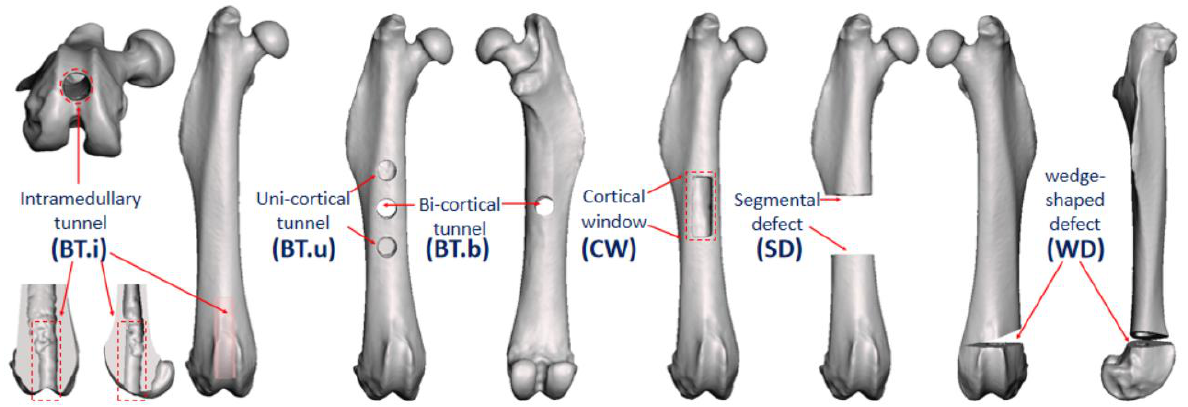
Figure 5. Classification of modeling methods. Note: BT.i: bone tunnel, intramedullary; BT.u : bone tunnel, uni-cortical; BT.b : bone tunnel, bi-cortical; CW : cortical window; SD : segmental defect; WD : wedge-shaped defect.